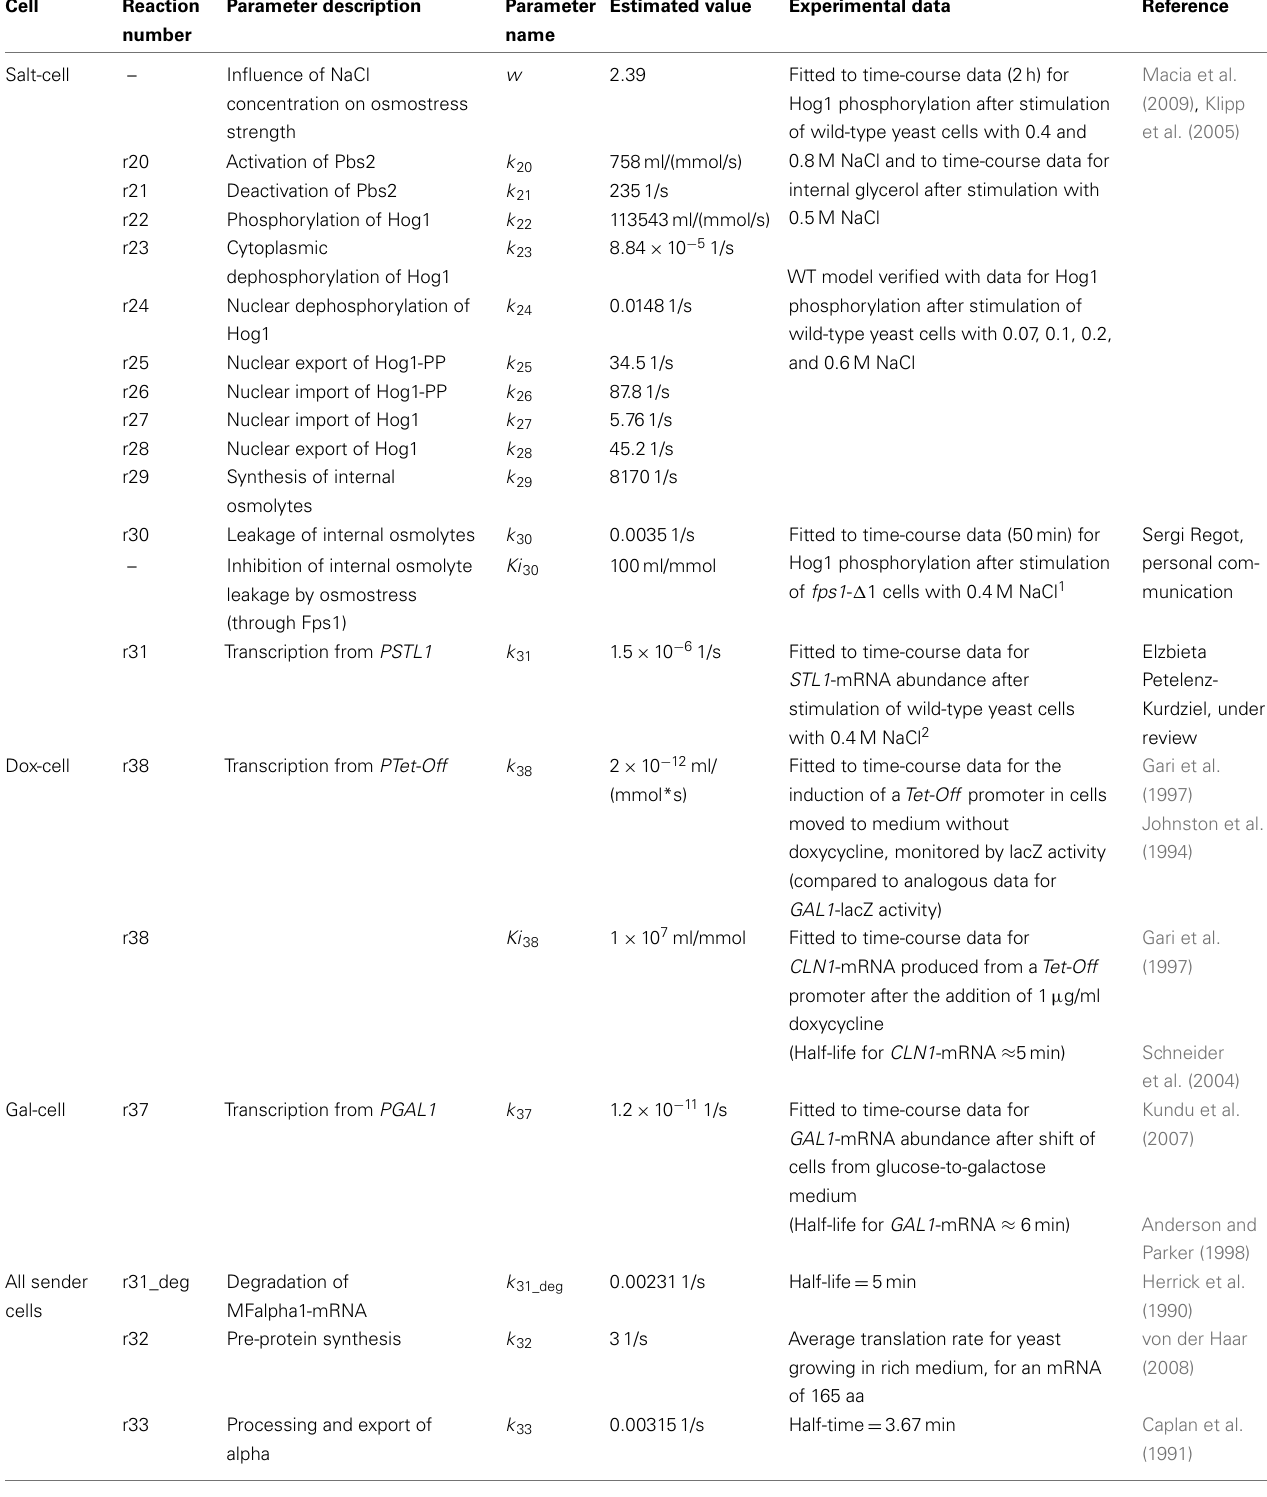
Table 1 | Data used for model fitting and obtained parameter